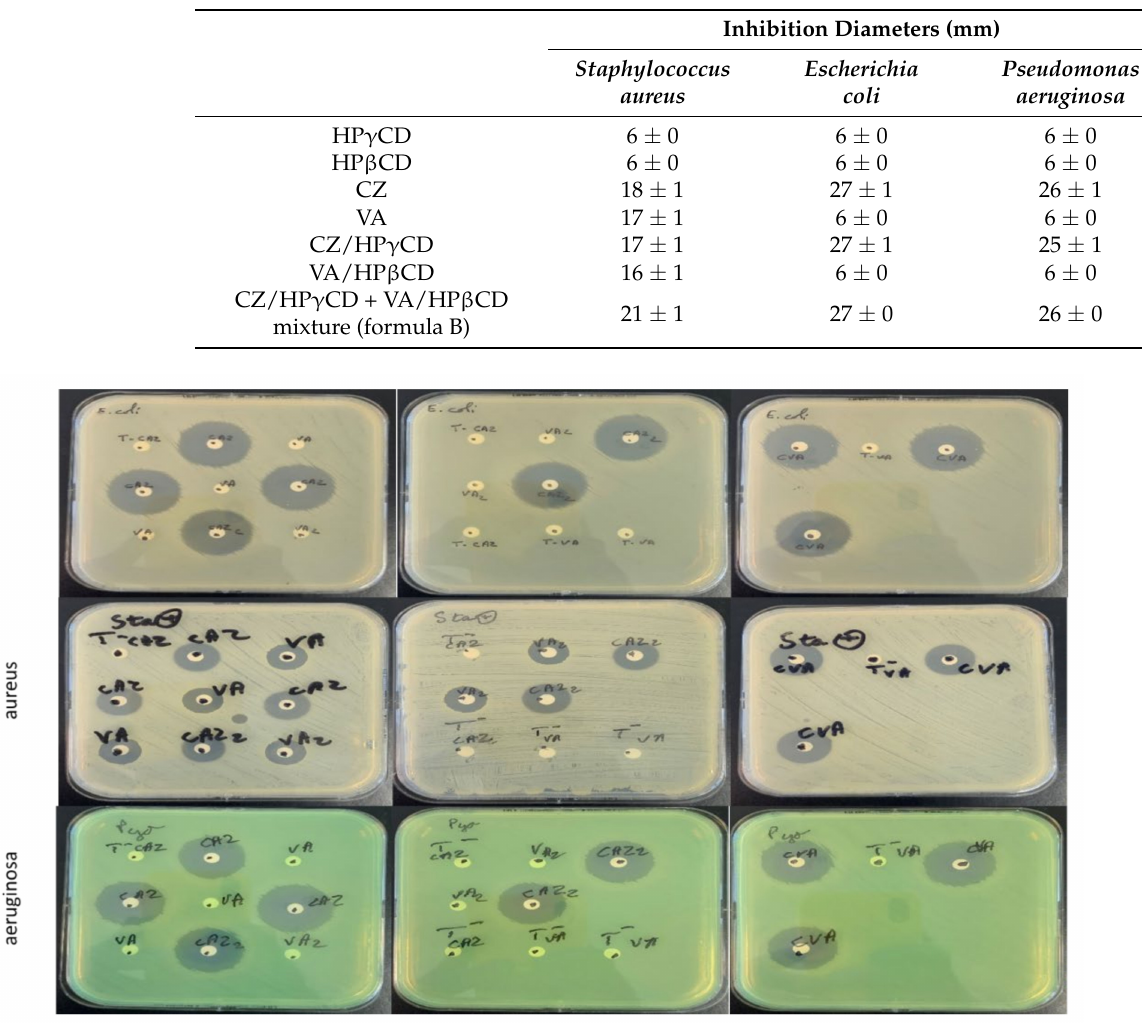
Table 3. Inhibition diameters of the tested solutions against Escherichia coli , Staphylococcus aureus and Pseudomonas aeruginosa cultures. Mean ± standard deviation, n = 3. Hydroxypropyl- β -cyclodextrins: